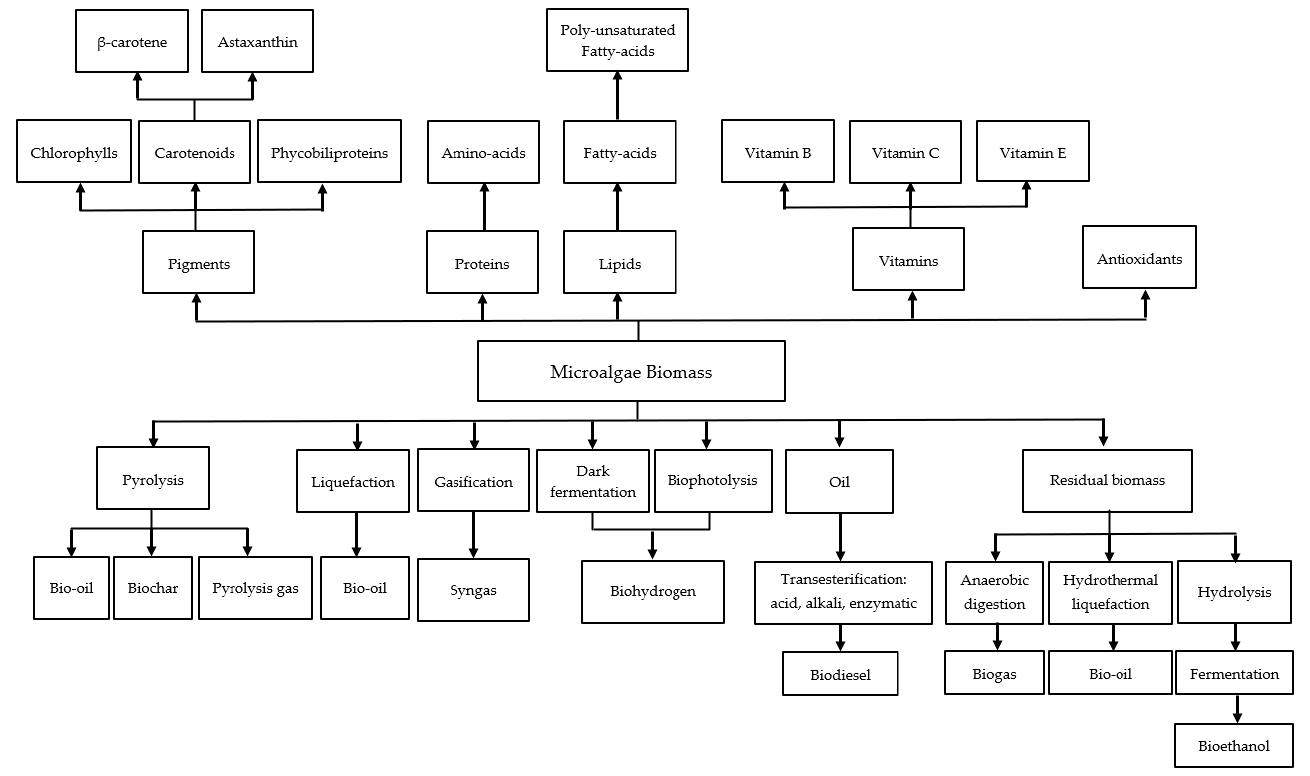
Figure 1. Primary processes used for converting microalgal biomass into biofuels, together with the major value-added products harvestable from microalgae.